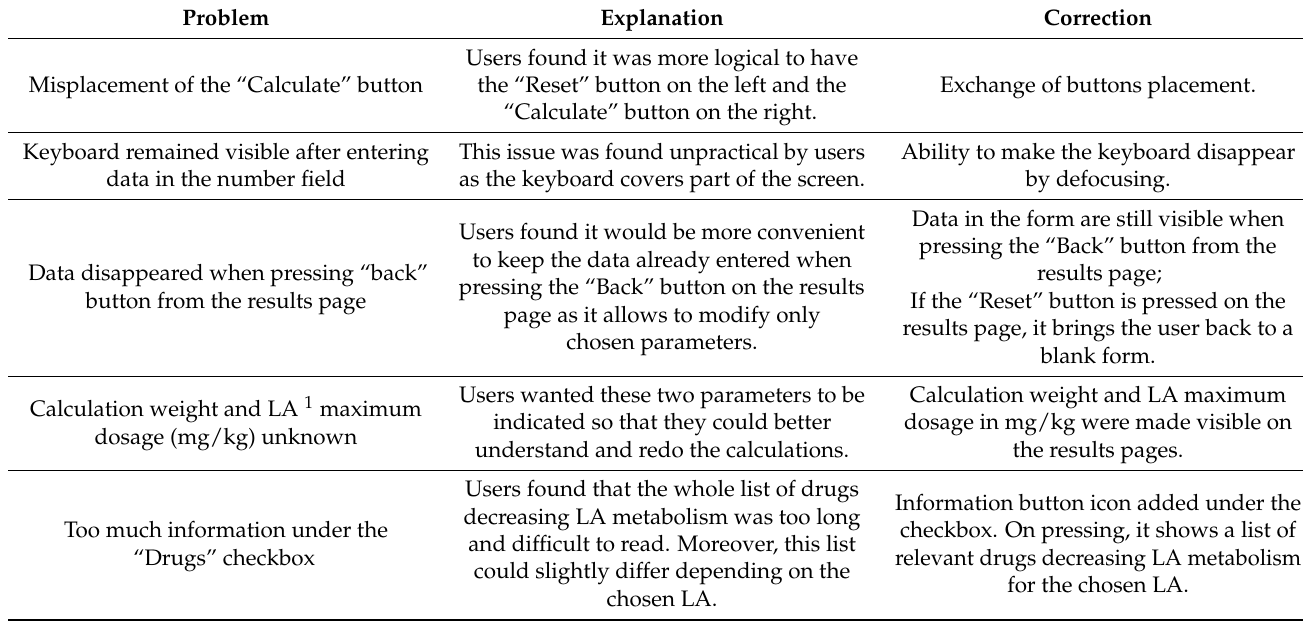
Figure 5. LoAD Calc, the final version of the app. Table 5. Corrections performed after testing the final